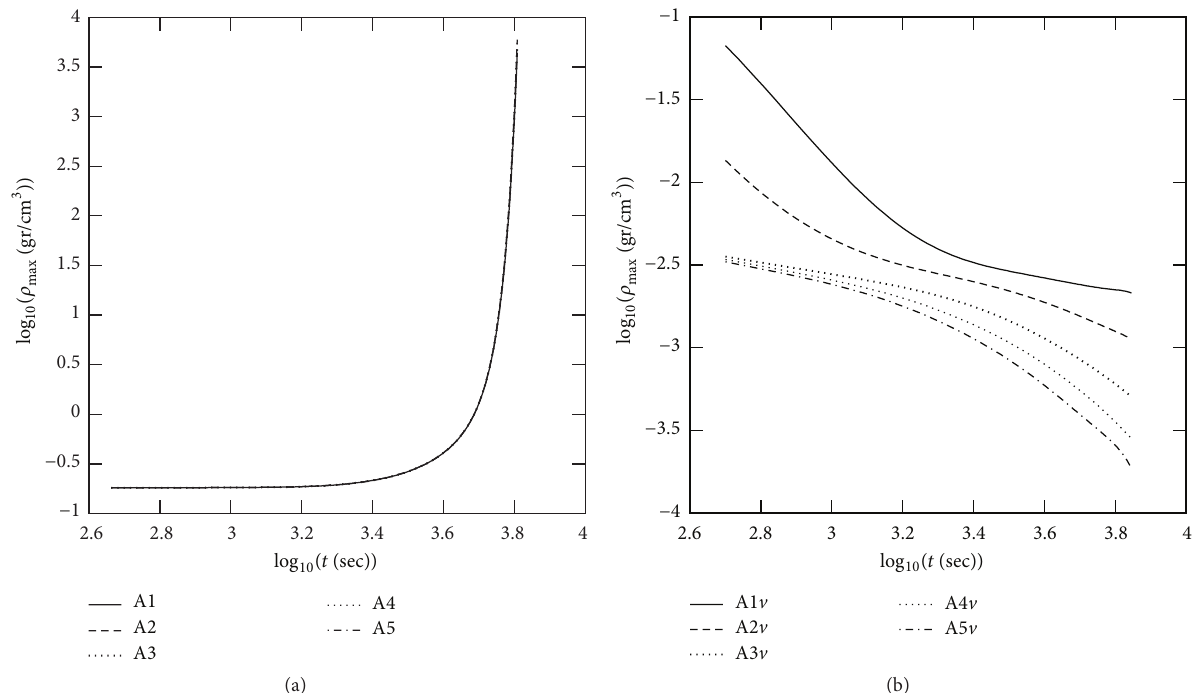
Figure 3: Evolution time of the peak density for the A models: (a) including all particles and (b) including only wind particles.